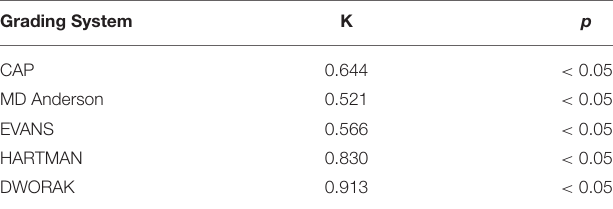
TABLE 3 | Level of concordance between